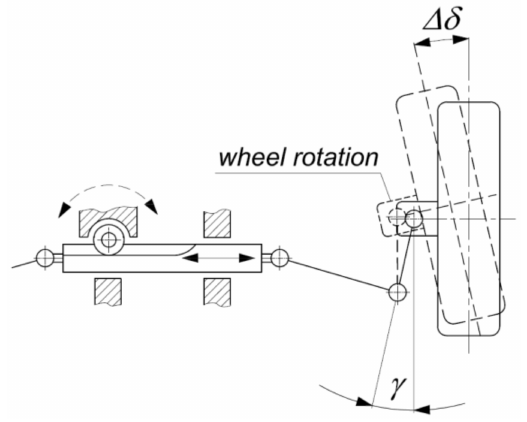
Figure 4. Change of the steering angle caused by clearance on the rocker arm pin: ∆ δ —changing the steering angle of the wheel, γ —steering arm inclination angle.